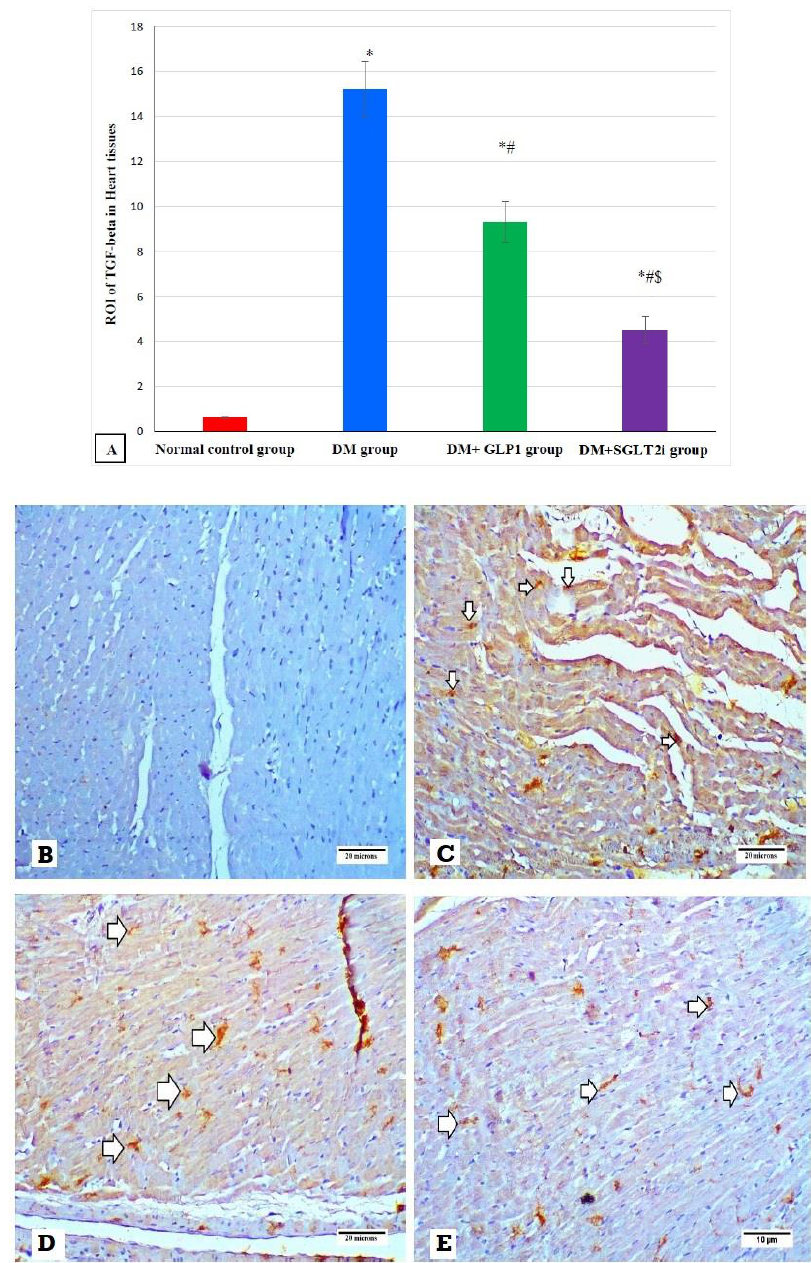
Figure 7. The expression of TGF- β by immunostaining in di ff erent groups. ( A ) Graphs of ROI of the expression of TGF- β in di ff erent groups. Heart specimens showing ( B ) negative TGF- β expression (control group), ( C ) marked membranous expression of TGF- β within the interstitial tissue between fibers (arrows) (DM group), ( D ) moderate membranous expression of TGF- β (arrows) (DM + GLP1 group), and ( E ) minimal membranous expression of TGF- β (arrows) (DM + SGLT2i group). * Significant vs. control group, # significant vs. DM group and $ significant vs. GLP1